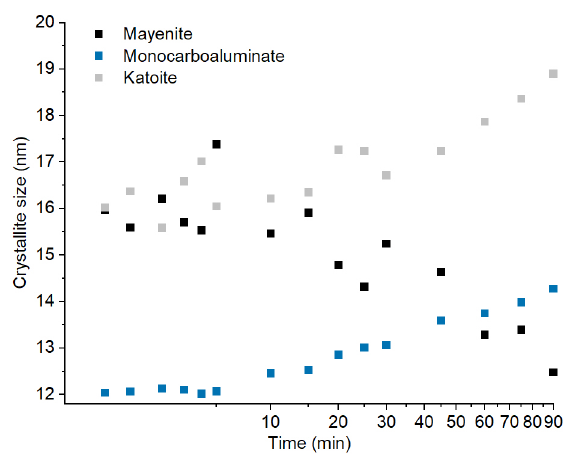
Figure 7. Average crystallite size of monocarboaluminate, katoite, and mayenite as a function of time in cubic root scale. Rheometry